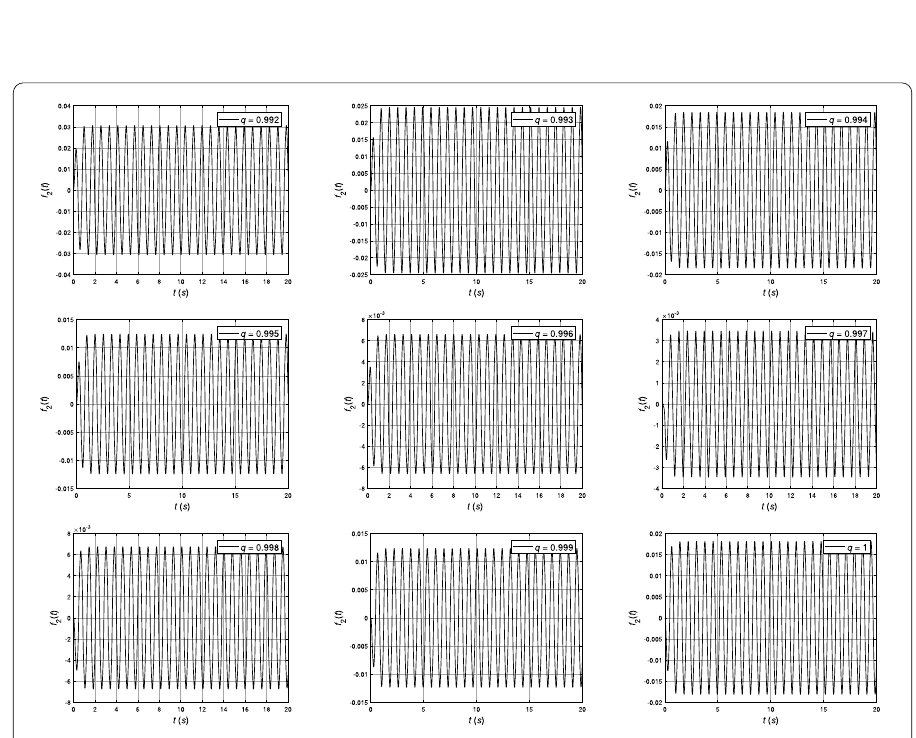
Figure 8 The state variable f 2 ( t ) of the controlled system (35) for q = 0.992,0.993,0.994,0.995,0.996,0.997,